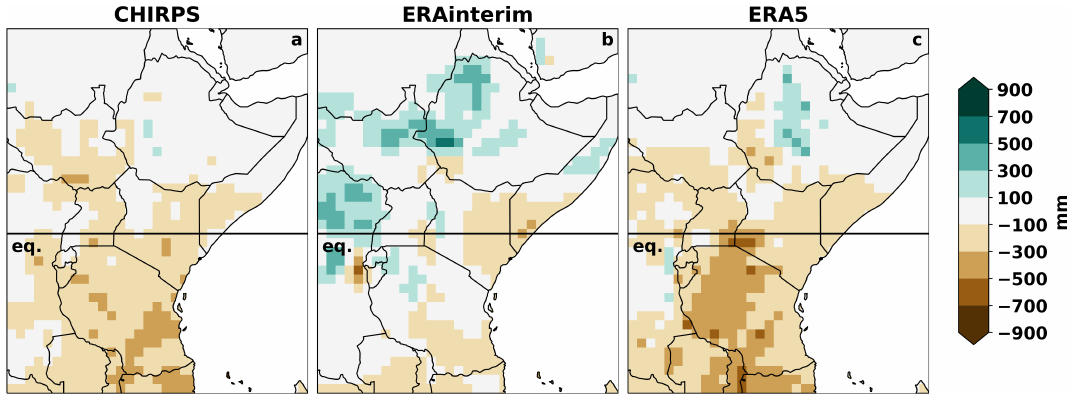
Figure 11. 2005 annual precipitation anomalies in East Africa in CHIRPS ( a ), ERA-interim ( b ) and ERA5 ( c ).